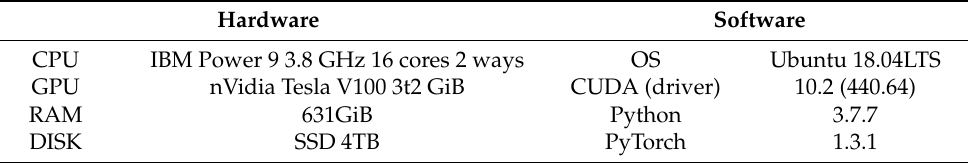
Table 3. The experimental environments of hardware and software for deep